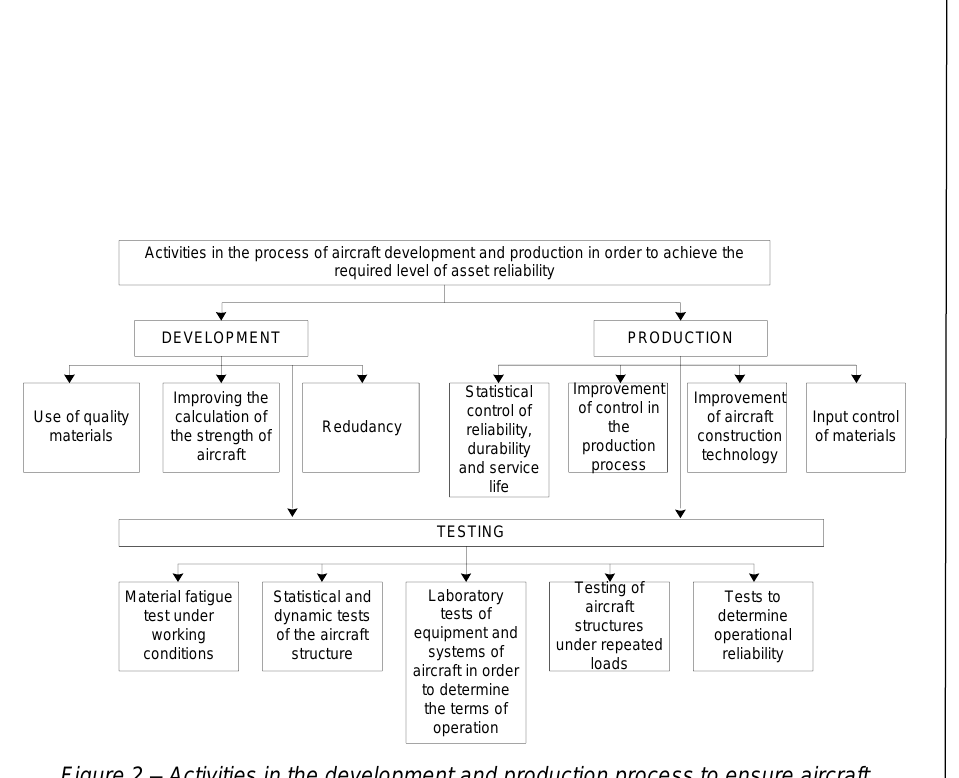
Figure 2 – Activities in the development and production process to ensure